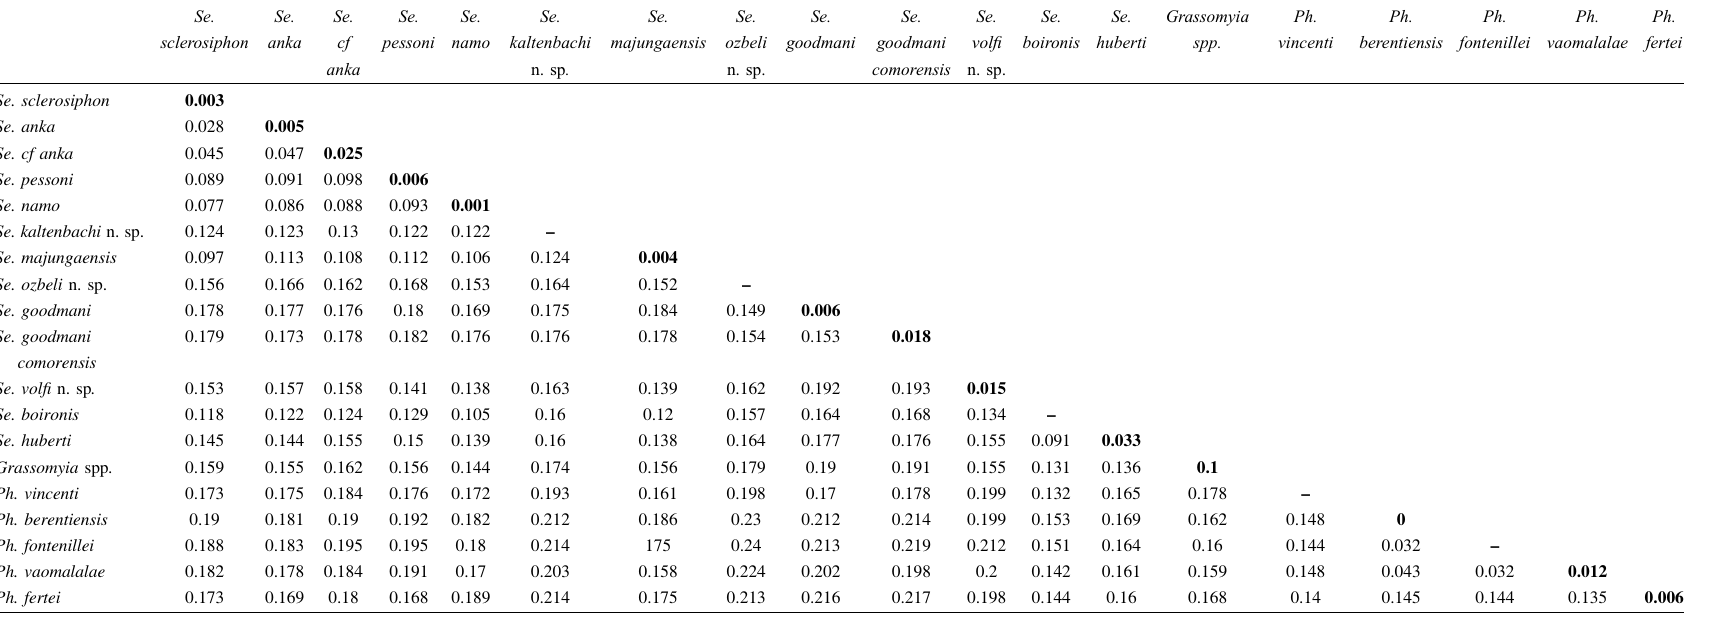
Ph. Ph. vincenti berentiensis